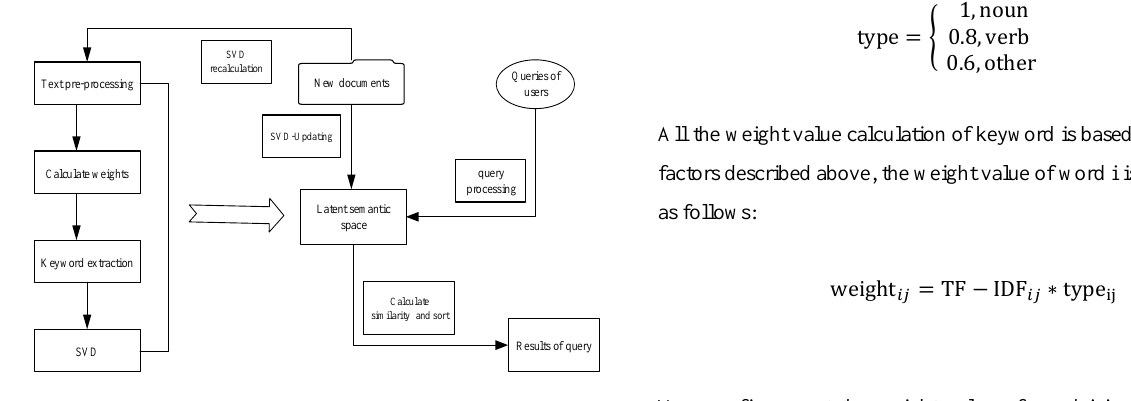
Figure 1. The match method based on